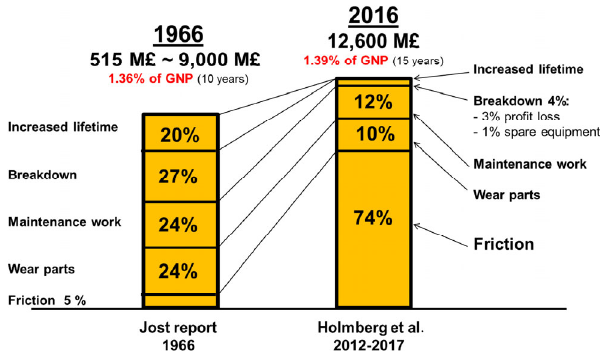
Fig. 13 Potential savings in UK 1966 and 2016 by implementing new tribology in machines and equipment, 515 million UK pounds converts to 9,000 million UK pounds of 2017